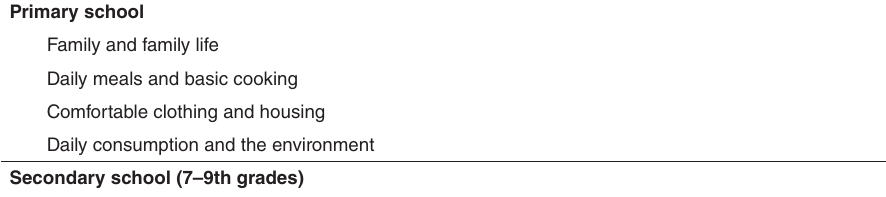
Table 1: Kateika syllabus in Japan Primary school Family and family life Daily meals and basic cooking Comfortable clothing and housing Daily consumption and the environment Family, home, and child development Food, cooking, and independent life Clothing, housing, and independent